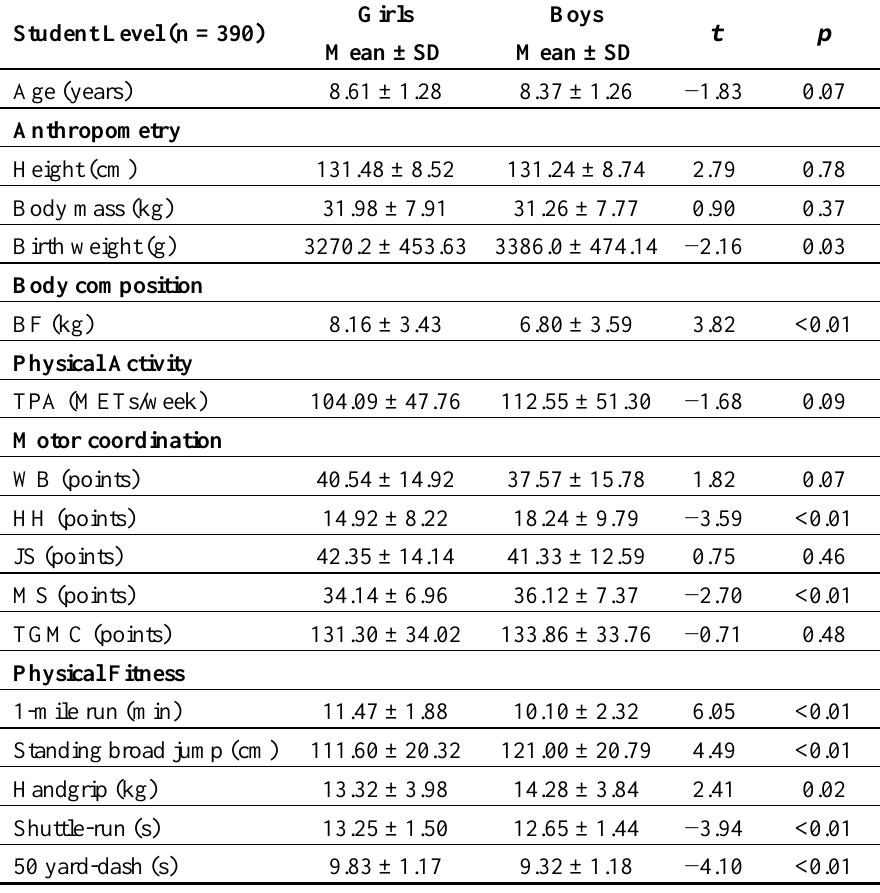
Table 1. Descriptive statistics for all variables at student level (level